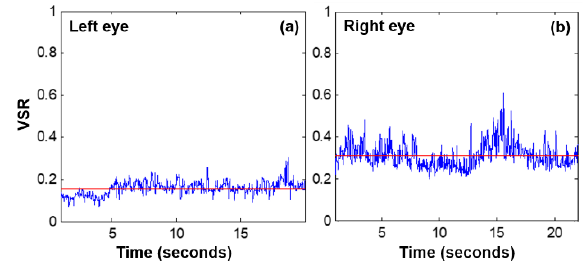
Fig. 2. VSR as a function of time under binocular conditions for one subject. Red line: Averaged VSR